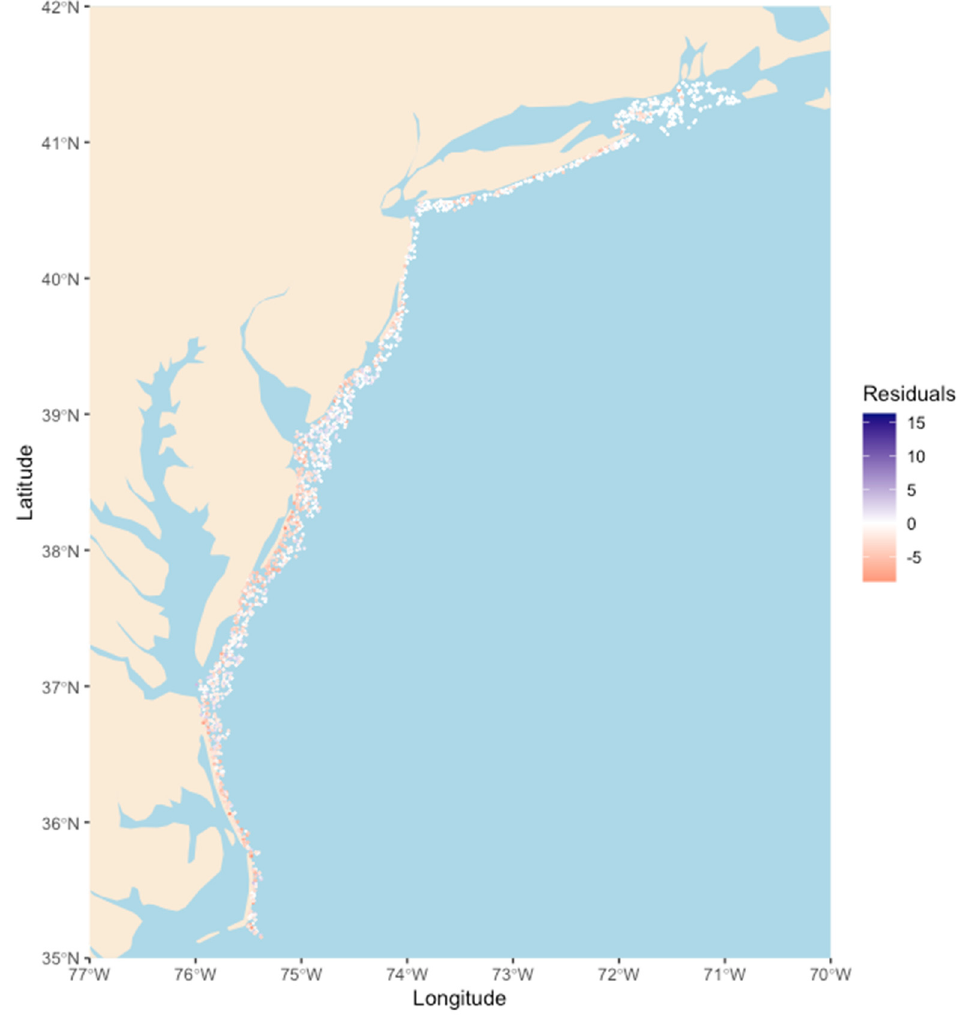
Figure A4. Map of residuals from delta SAR error model fitted to NEAMAP weakfish survey data. Blue indicates positive, red indicates negative, and color darkness is proportional to the value of residuals.